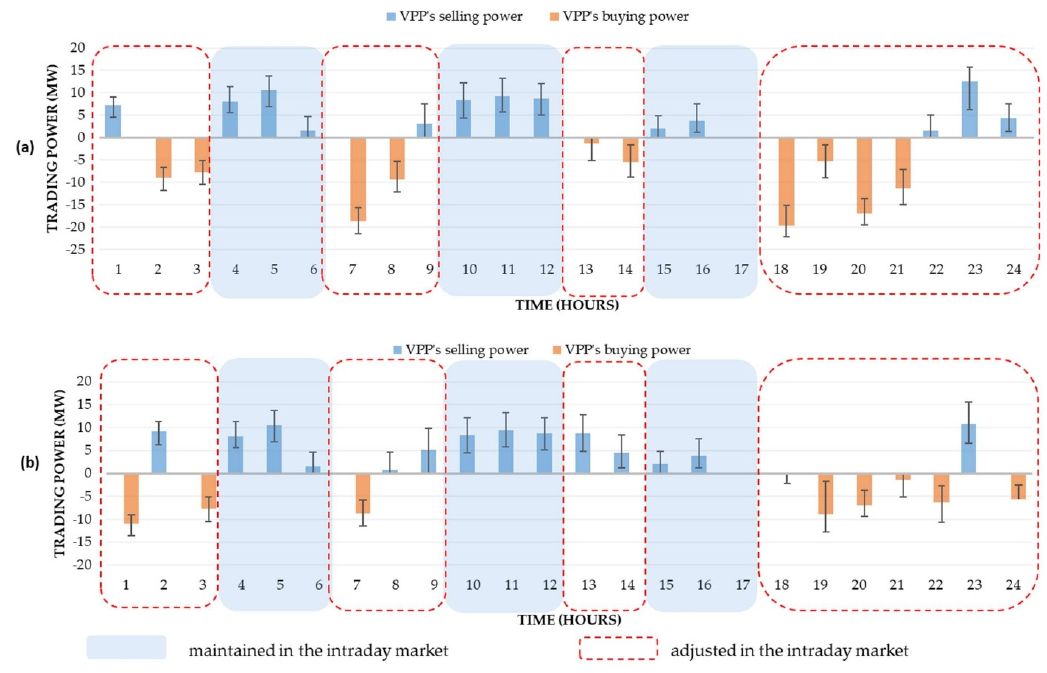
Figure 8. The VPP’s selling/buying power with scenario p 1 of the reserve probability: ( a ) The reserve bid is called on to produce; ( b ) the reserve bid is not called on to produce.